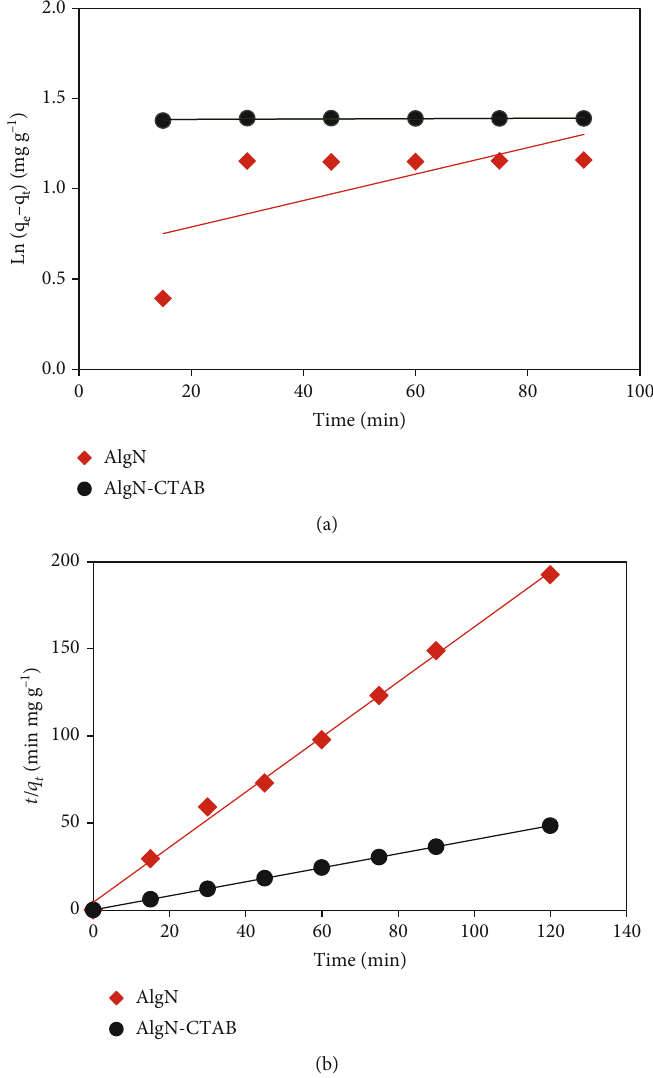
Figure 8: Linearized (a) PFO and (b) PSO kinetic models on adsorption of MO dye. Table 1: Kinetic parameters for the adsorption of MO dye on AlgN and